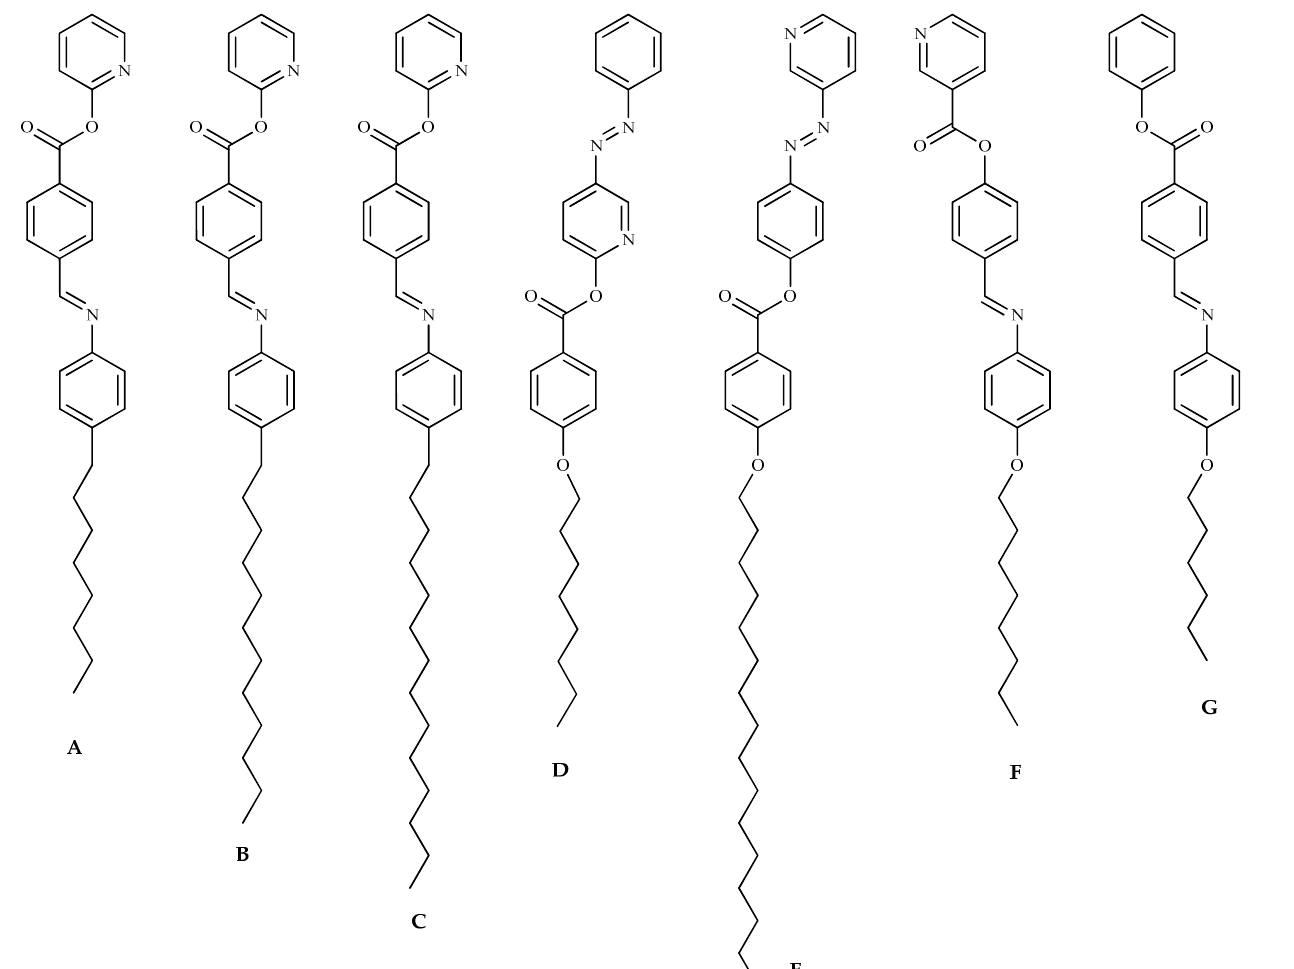
Figure 1. The investigated compounds A , B , C , D , E , F , G , H , and I .